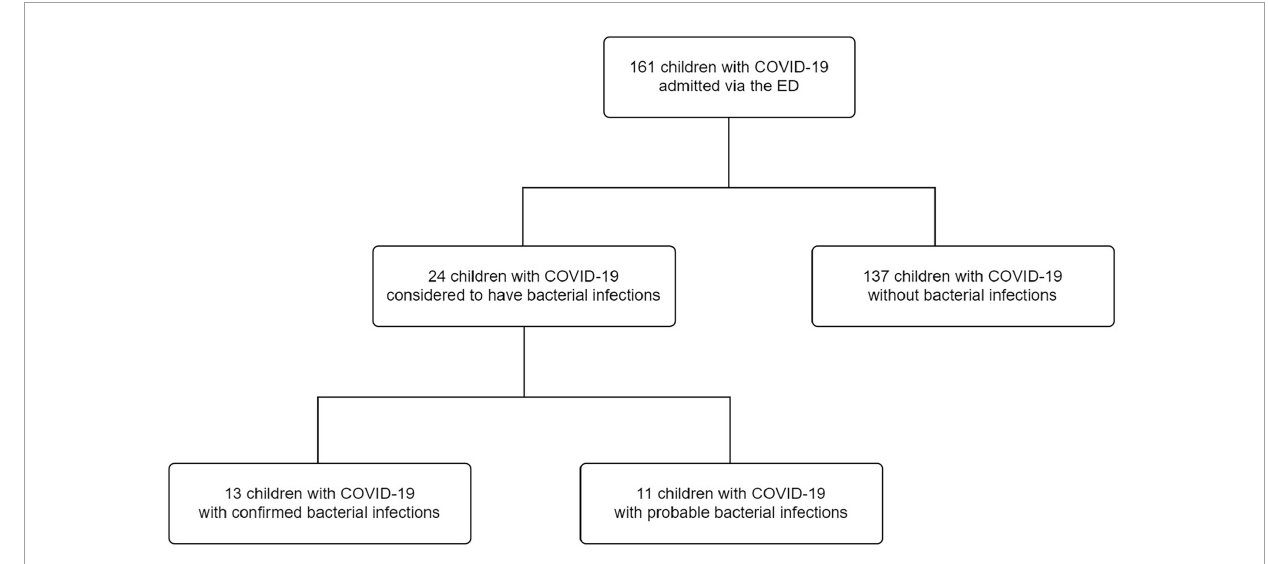
FIGURE1 Flow diagram of the study participants. COVID-19, coronavirus disease 2019; ED, emergency department.